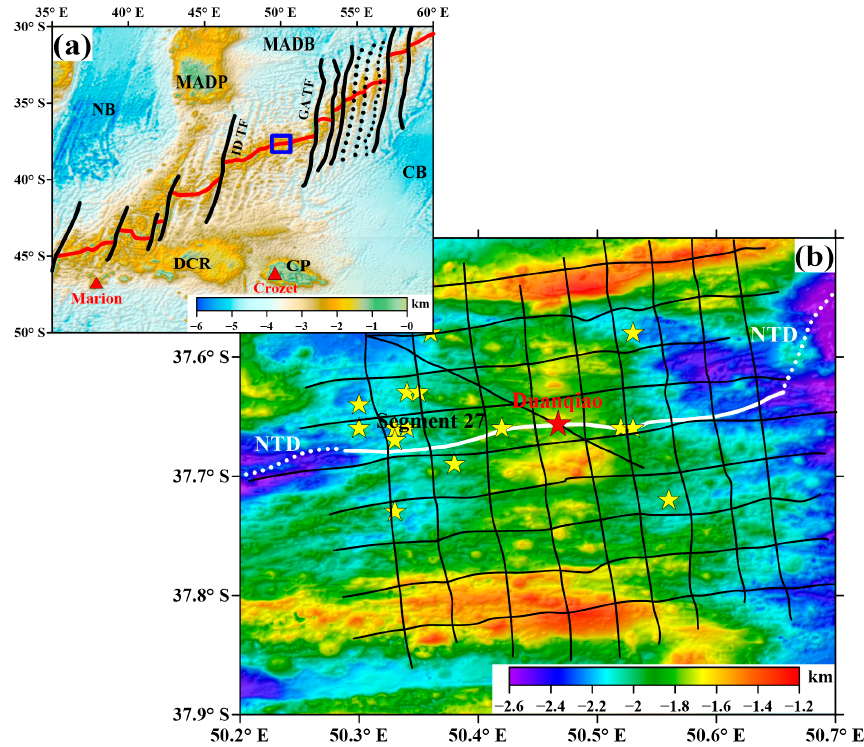
Figure 1. ( a ) Seafloor topographic map from ETOPO1 global topography data [36] in the Southwest Indian Ocean. Solid red lines represent the SWIR’s spreading center. Solid black lines represent transform faults (TFs). Red triangles represent hotspots. The blue square refers to the study area. Tectonic unit names are abbreviated. TFs include the Indomed (ID) and Gallieni (GA) TFs. Hotspots include the Marion and Crozet hotspots. Main structures include the Madagascar Plateau (MADP), Del Cano Rise (DCR), Crozet Plateau (CP), Madagascar Basin (MADB), Natal Basin (NB), and Crozet Basin (CB). ( b ) Bathymetry map from ship-borne multi-beam seafloor topography data in segment 27 and the surrounding area. The solid white line and dotted white lines represent segment 27’s axis and two NTDs, respectively. The red star denotes the Duanqiao hydrothermal field. Yellow stars represent several hydrothermal plume anomalies [17]. Solid black lines represent all surveyed lines.